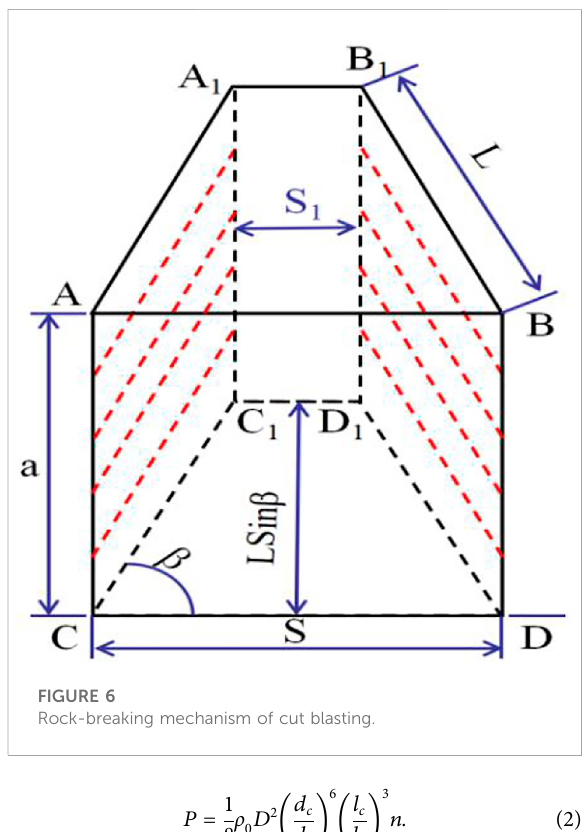
FIGURE 6 Rock-breaking mechanism of cut